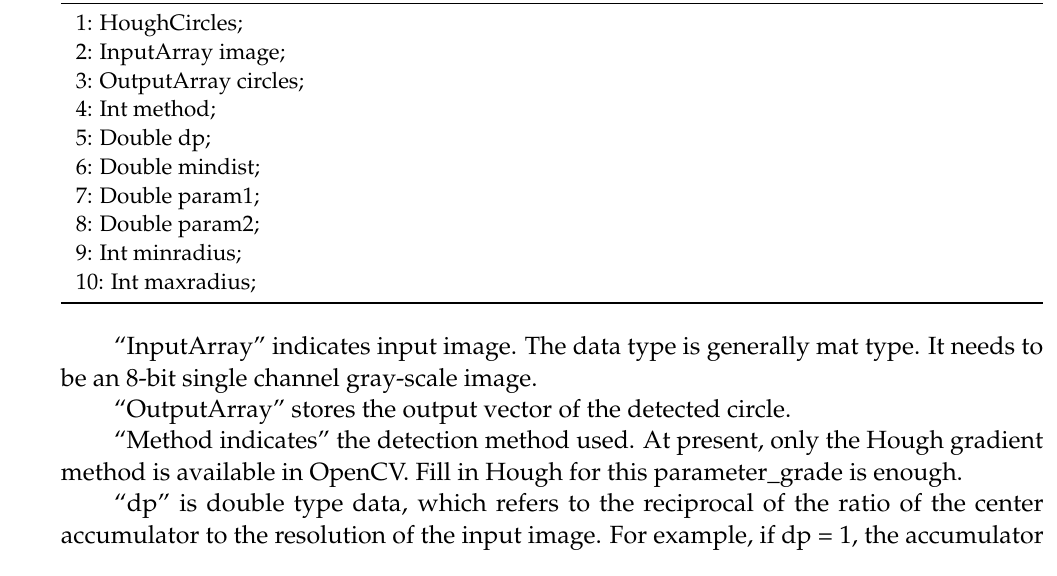
Algorithm 1. The process of Hough circle detection algorithm based on image